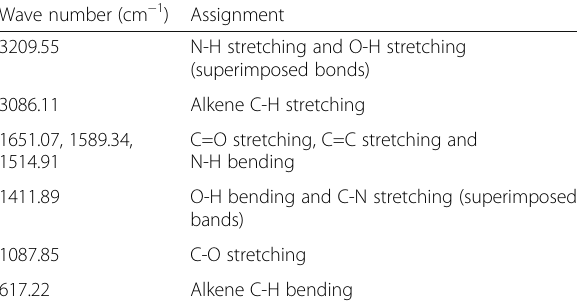
Table 4 The FT-IR functional groups of purified